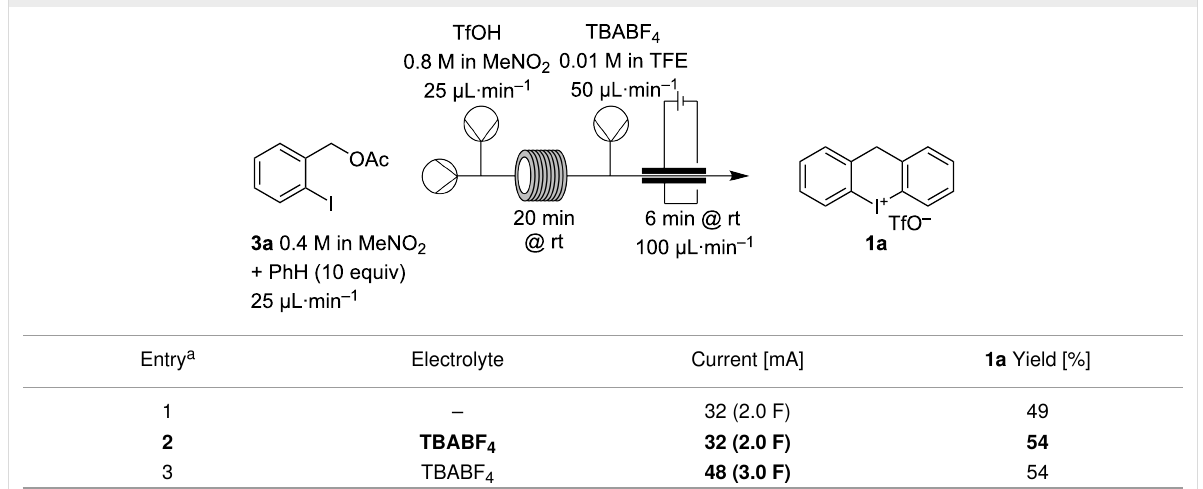
Table 3: Optimization of the two-step flow process in series.